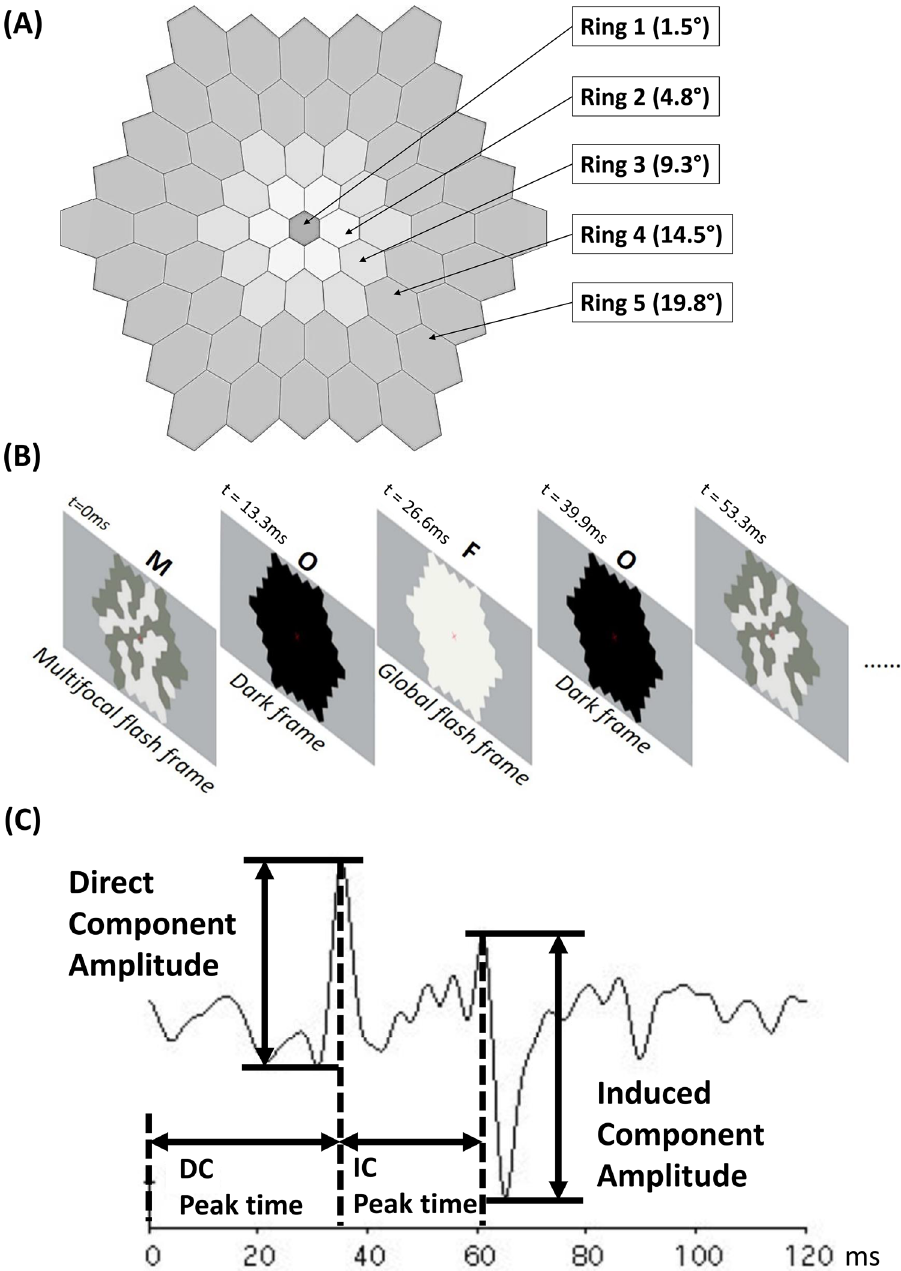
Figure 1. Schematic diagram showing the pattern of MOFO mfERG stimulation. ( A ) Stimulation pattern coverage and regions. ( B ) Video frame sequence. ( C ) A typical MOFO mfERG response with direct and induced